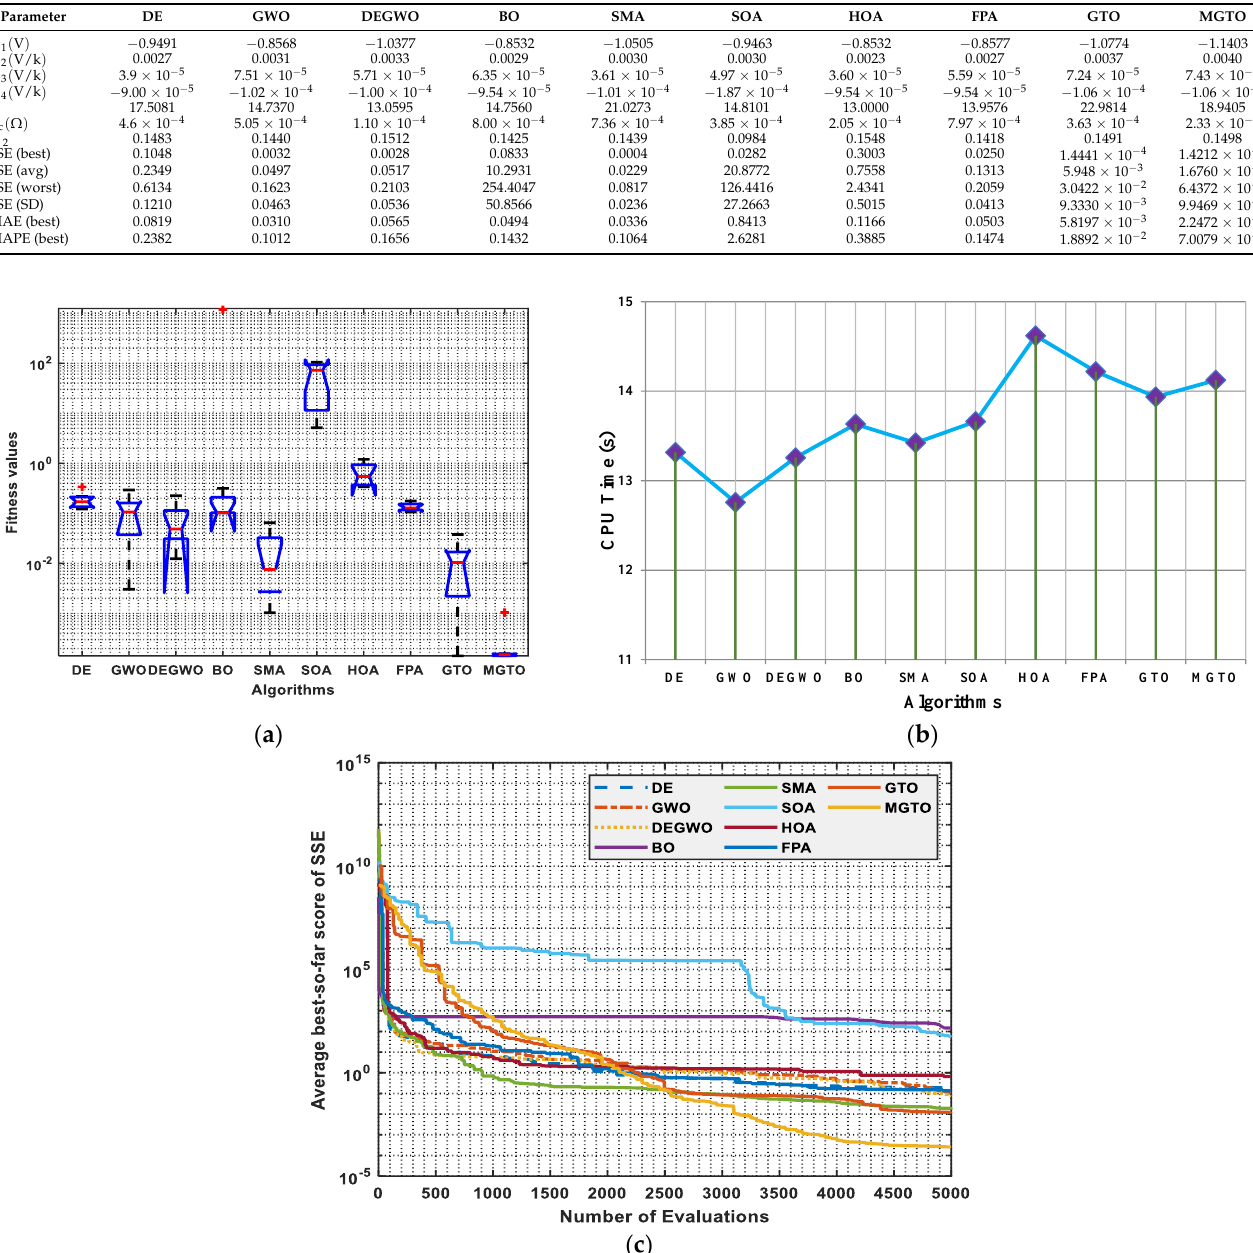
Table 7. Comparison among algorithms using test case 3.